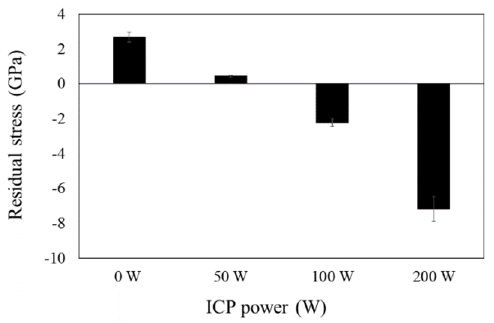
Figure 2. Residual stresses (compressive or tensile) of MoN coatings deposited using ICP assisted sputtering with various ICP powers. Table 2. Lattice plane spacing and lattice parameters of Mo 2 N films (f), compared with bulk (b), and theoretical values (th).